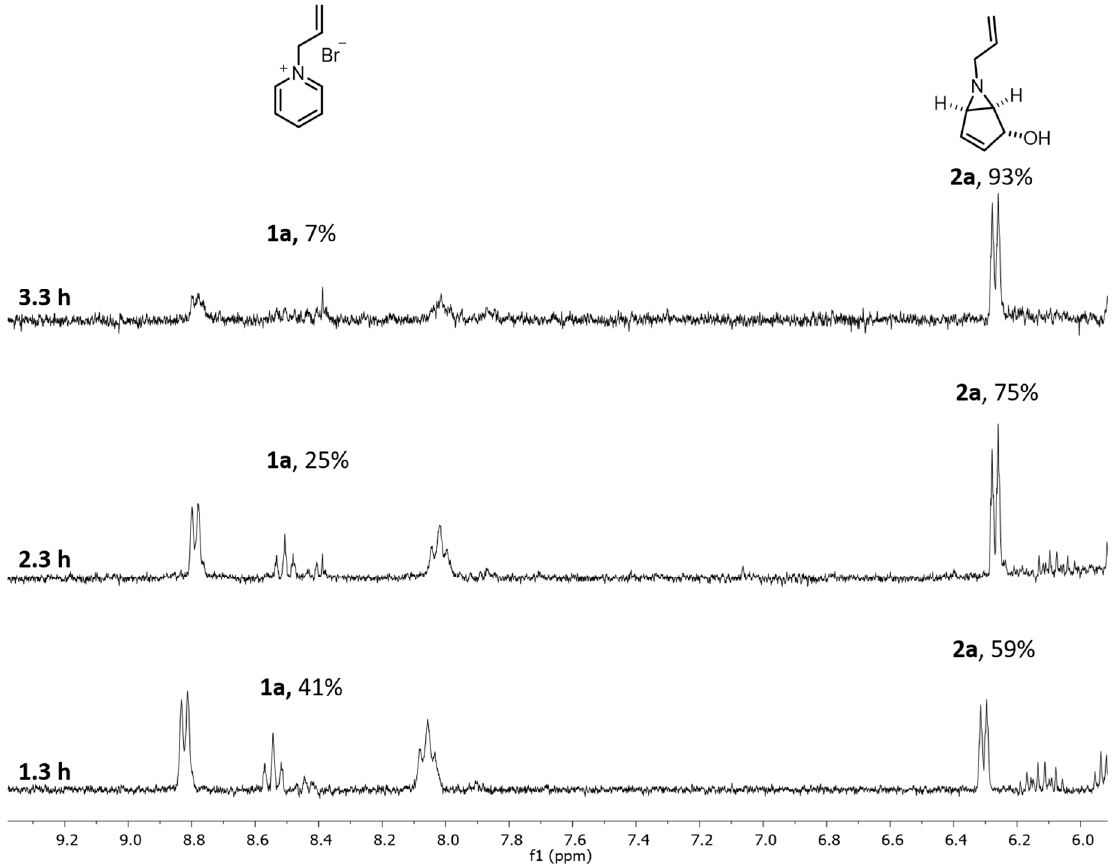
Figure 4. 1 H NMR profile for continuous-flow experiments optimization of 1a to 2a at 20 mM, with